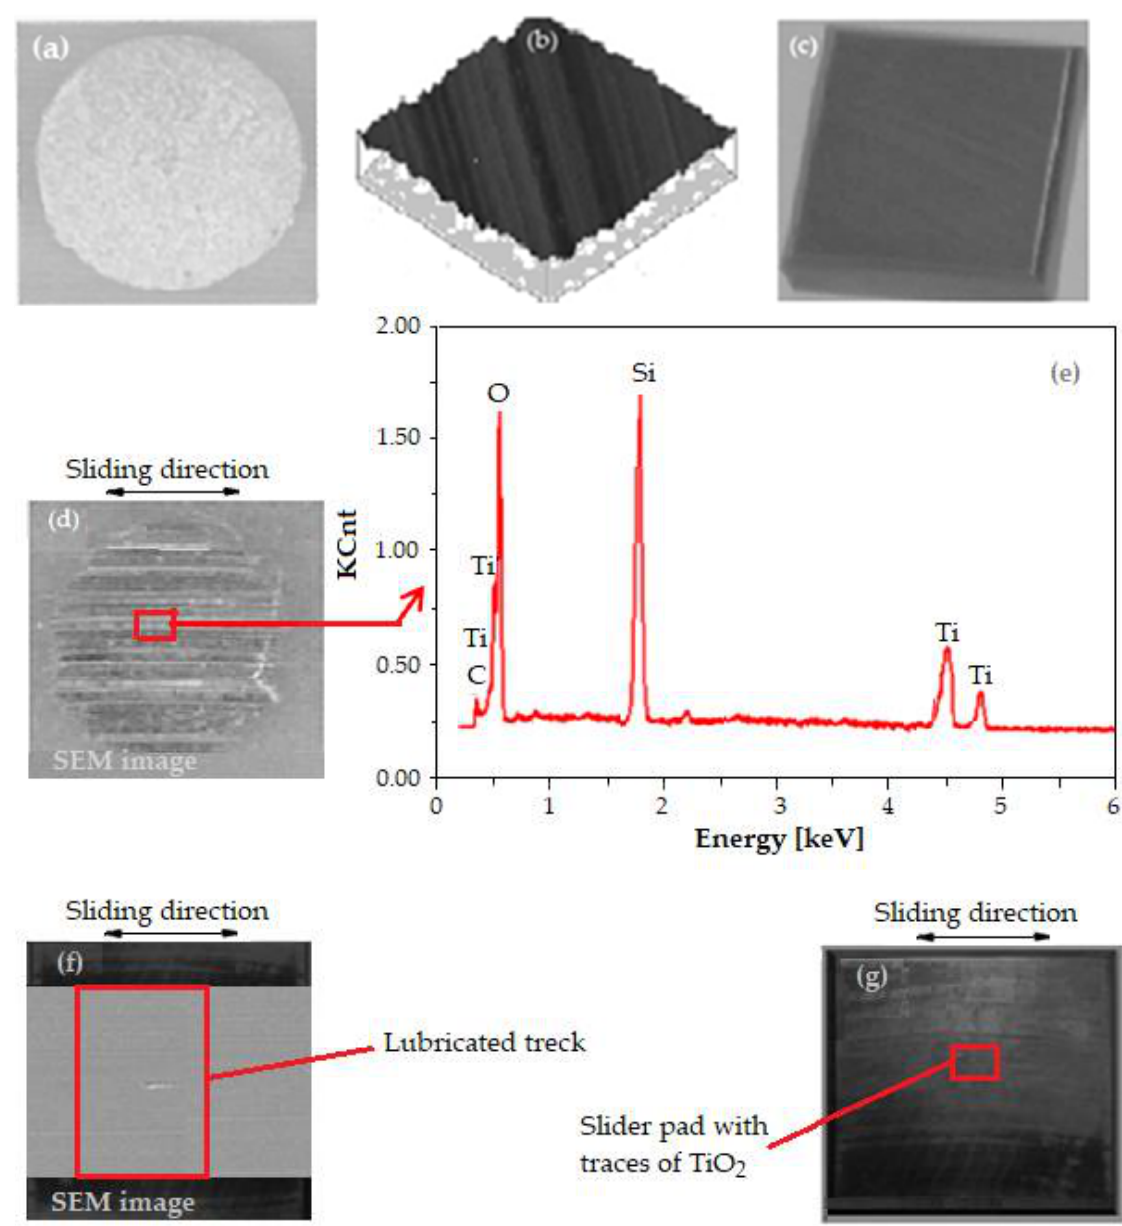
Figure 6. Images before testing ( a – c ) and after testing ( d – f ): ( a ) photography of the TiO 2 pellet (front view), ( b ) AFM image from an area of the route (contact) where the lubrication track is made on the TiC disk, ( c ) photograph of the TiC slider pad; ( d ) SEM micrograph of the TiO 2 pellet, ( e ) EDS pattern of area in position ( d ) from Figure 6; ( f ) SEM micrograph of the lubricated track; ( g ) photograph of the TiC slider